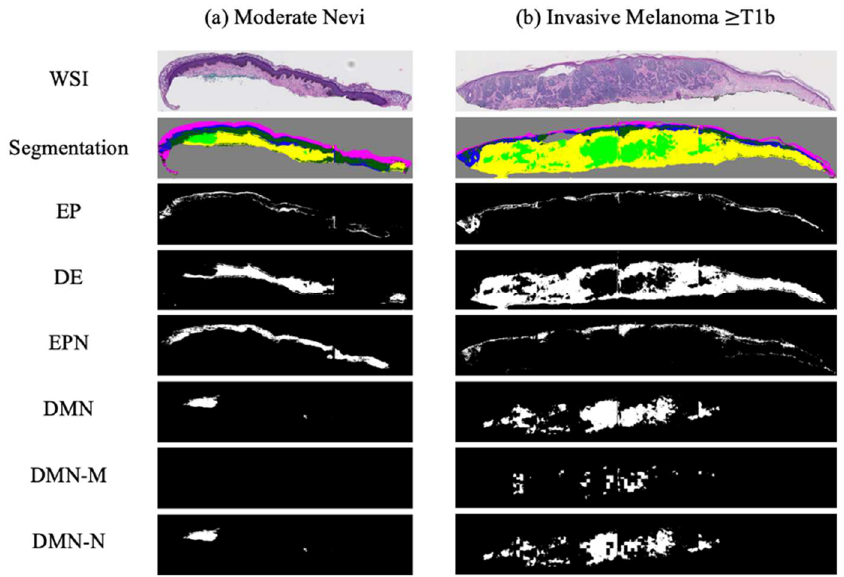
Figure 7. Examples of binarized segmentation masks: ( a ) a moderate nevi case; ( b ) an invasive melanoma stage ≥ T1b. From top to bottom, one extracted slice from a WSI, all segmentation masks in one mask (containing EP, DE, EPN, and DMN), binary Epidermis (EP) mask, binary dermis (DE) mask, binary epidermal nest (EPN) mask, binary dermal nest (DMN) mask, binary melanoma dermal nest (DMN-M), and binary nevus dermal nest (DMN-N) mask are shown.